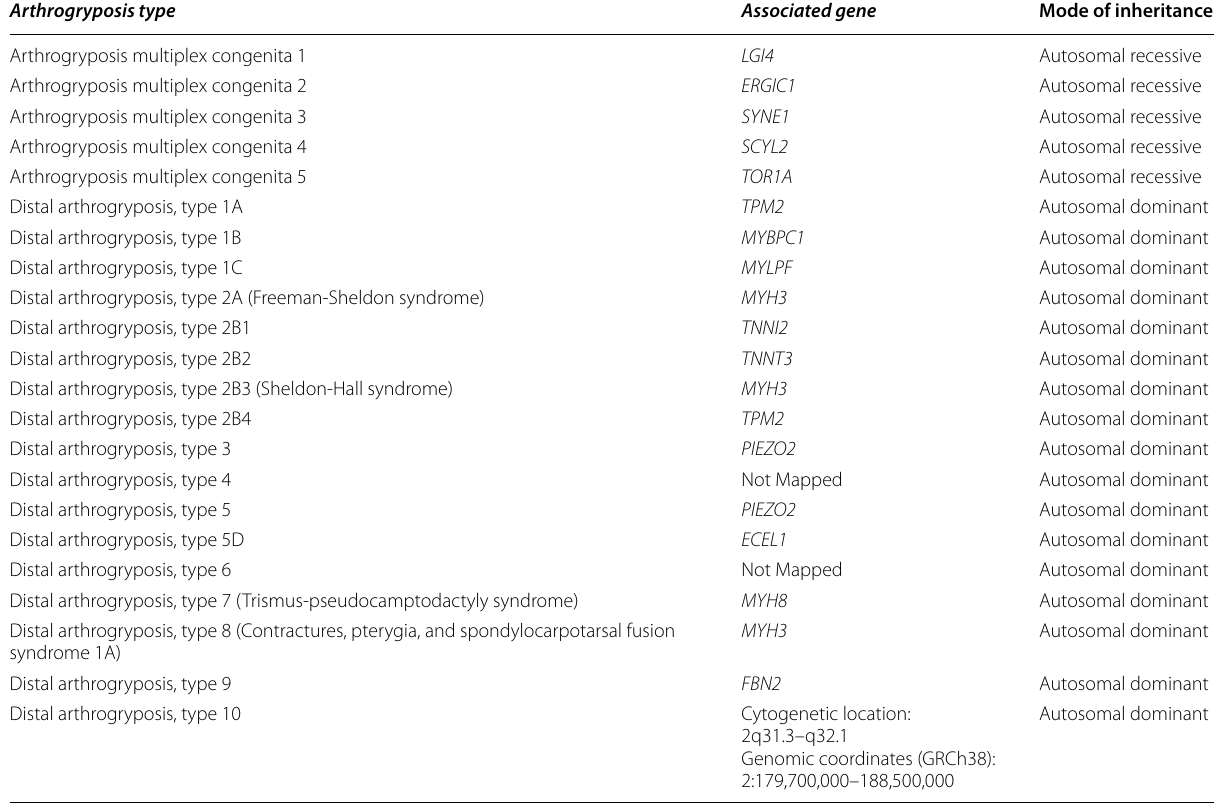
Table 1 List of genes associated with different arthrogryposes [6] Arthrogryposis type